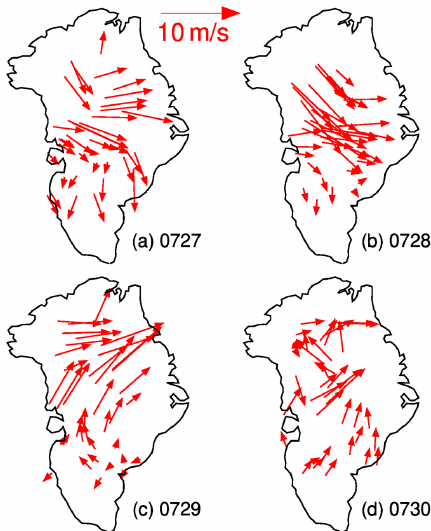
Figure 14. Wind direction (referenced to the north) and wind speed (unit: m/s) over Greenland during 27–30 July 2017 (data from